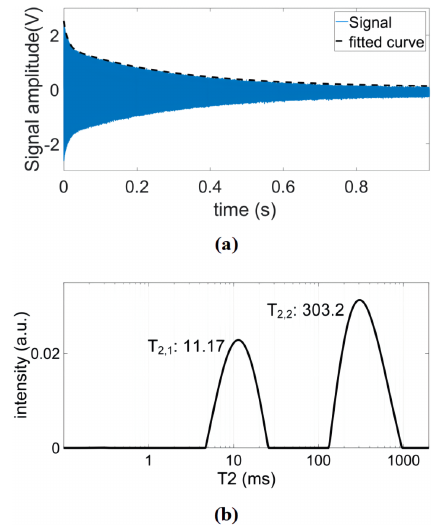
Figure 11. (a) An example time-domain CPMG signal of the con- structed sample containing solutions with two different concentra- tions of copper sulfate doped water (5 and 75mM). (b) The corre- sponding T 2 distribution after inverse Laplace transform.